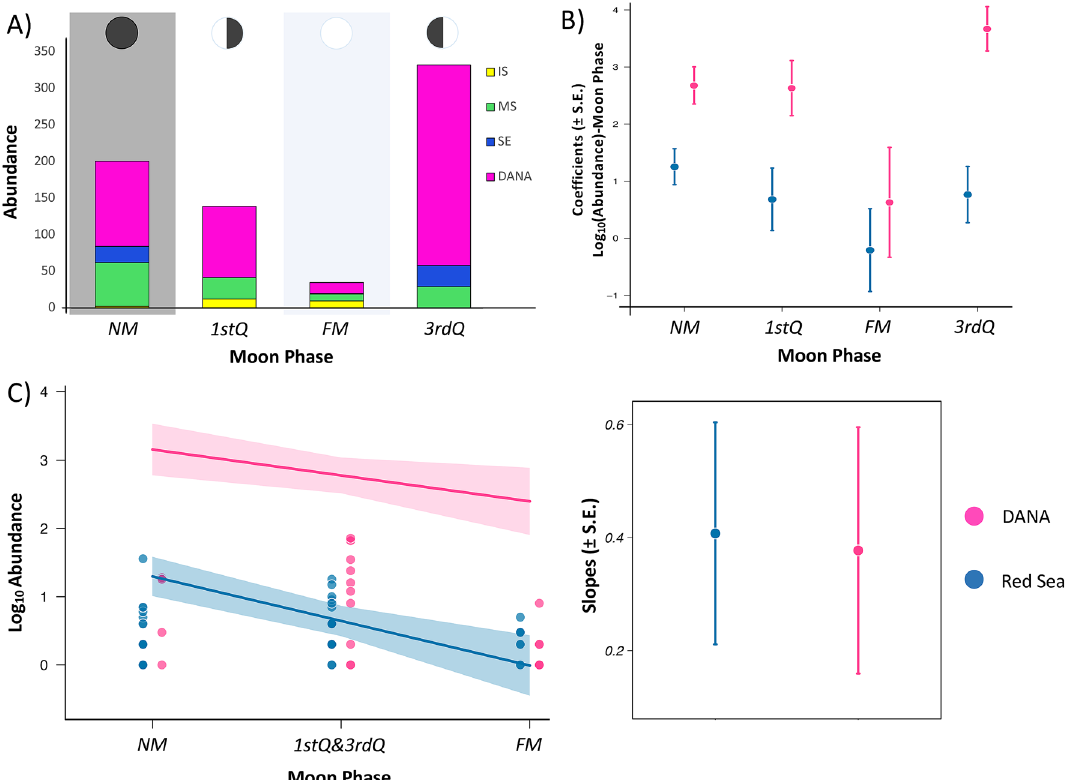
Figure 5. Relations between abundances of adult LDF Schindleria and the four main moon phases (the new moon “NM”, the 1st quarter “1stQ”, the full moon “FM”, and the 3rd quarter “3rdQ”) in two different datasets: one from an Indo-Pacific collection from the DANA Expedition 1928–1930 (DANA) and the other from a Red Sea collection (from the 16th Oct to the 16th Nov, 2014). Values from the DANA Expedition are always color-coded in “pink”. Panel A displays the abundances in the Red Sea color-coded per sampling site: inshore/ IS reef in “yellow”, mid-shelf/MS reef in “green”, and shelf-edge/SE reef in “blue”. In Panel B and C, the Red Sea abundances are given as total values in “blue”. Panel A displays the total abundances (y-axis) for each dataset per moon phase (x-axis). The moon phases are represented by the circles on the top of the barplot and the brightest moon phase (FM) highlighted by a “light-blue” shaded box, while the darkest moon phase (NM) by a “black” shaded box. Panel B displays the coefficients of linear regression on the corrected Log 10 Abundances (± SE; y-axis) of each moon phase (x-axis) of the two main datasets (DANA vs. Red Sea). Panel C displays, on the left plot, the abundances of each day of sampling (as dots) within a moon phase (on the x-axis; where the moon phases are grouped by light intensity for which the 1stQ and the 3rdQ moons are grouped in the middle of the regression) and on the right plot the respective slopes of the linear regression of both datasets of which the mean does not differ significantly between the two data sets. The lowest abundances of adult LDF Schindleria were generally during the